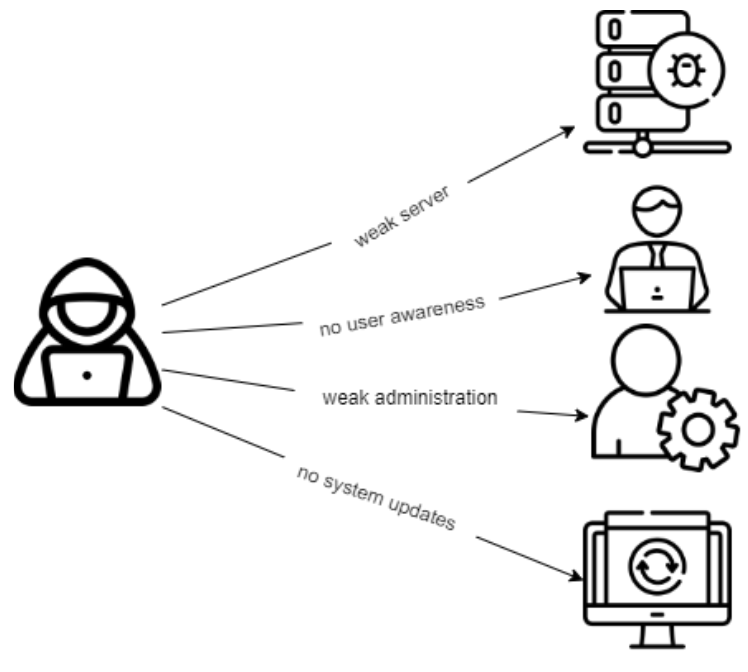
Figure 2. Defacement